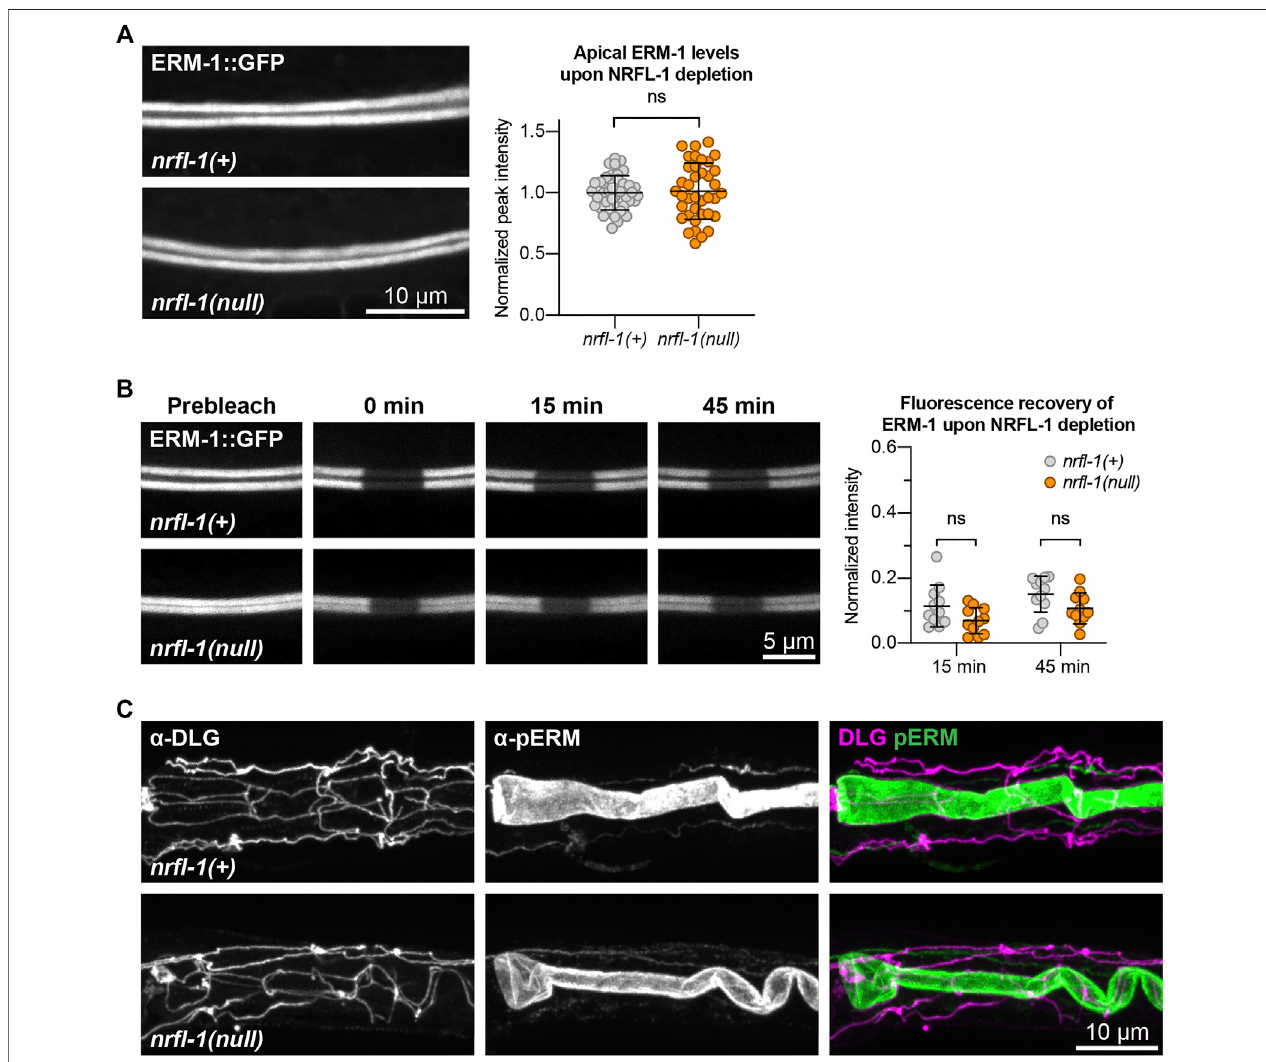
FIGURE5| NRFL-1 doesnotregulateERM-1 apical accumulation,dynamics,orphosphorylationstatus. (A) Representativeimages and quanti fi cation ofERM-1:: GFP levels at the apical membrane of intestines in nr fl -1(+) and nr fl -1(null) L4 larvae. Each data point represents a single animal, and values are normalized to the mean intensityincontrolanimals.Errorbars:mean ± SD.Statisticaltest:UnpairedStudent ’ st-test. nr fl -1(+)n (cid:1) 40, nr fl -1(null)n (cid:1) 38. (B) FRAPanalysisofapicalERM-1::GFPin the intestine of nr fl -1(+) and nr fl -1(null) L4 larvae. Fluorescence micrographs show representative examples. Graph shows the fl uorescence intensity of ERM-1 in the photobleached region at the apical intestinal domain during recovery. Each data point represents a single animal, and values are relative to prebleach levels. Error bars: mean ± SD. Statistical test: Unpaired Student ’ s t-test. n (cid:1) 11 for both genotypes and both timepoints. (C) Representative images of fi xed nr fl -1(+) and nr fl -1(null) larvae stained with antibodies recognizing the junctional protein DLG-1 ( α -DLG) and phosphorylated ERM-1 ( α -pERM).